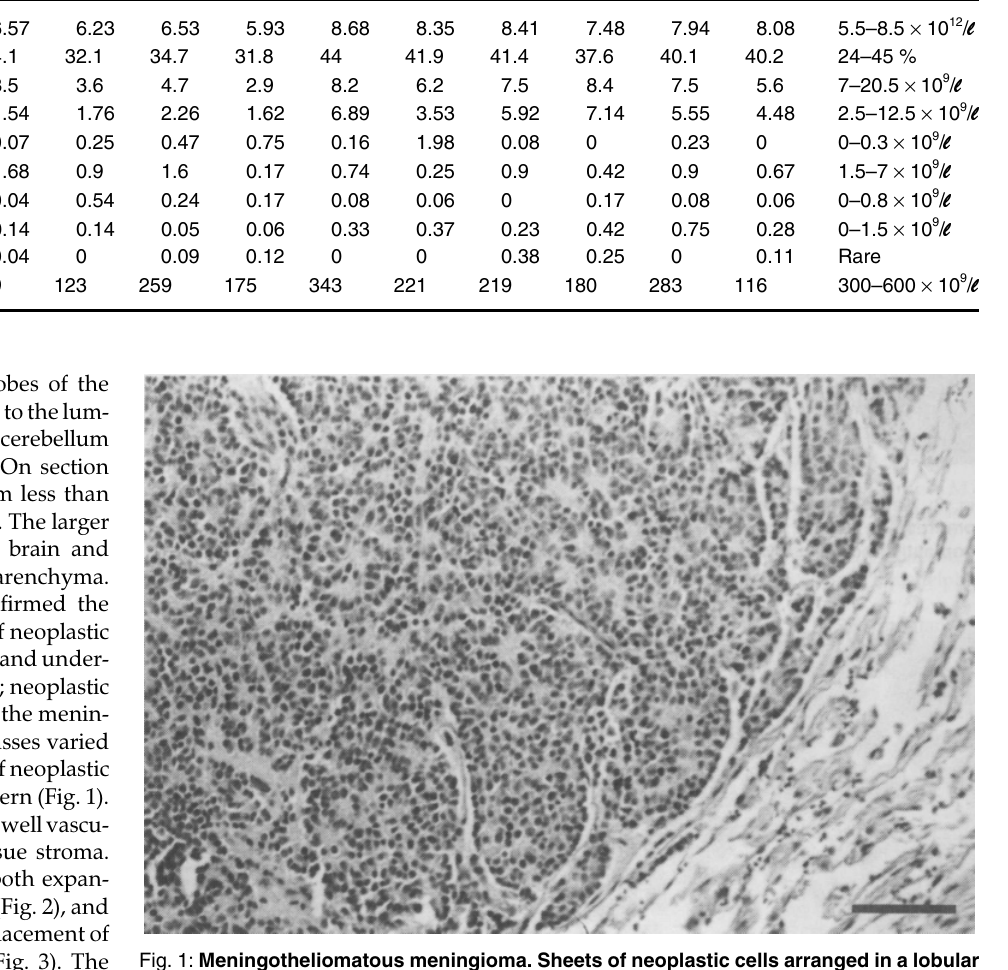
Fig. 1: Meningotheliomatous meningioma. Sheets of neoplastic cells arranged in a lobular pattern. Bar = 50 µ m. Haematoxylin and eosin.